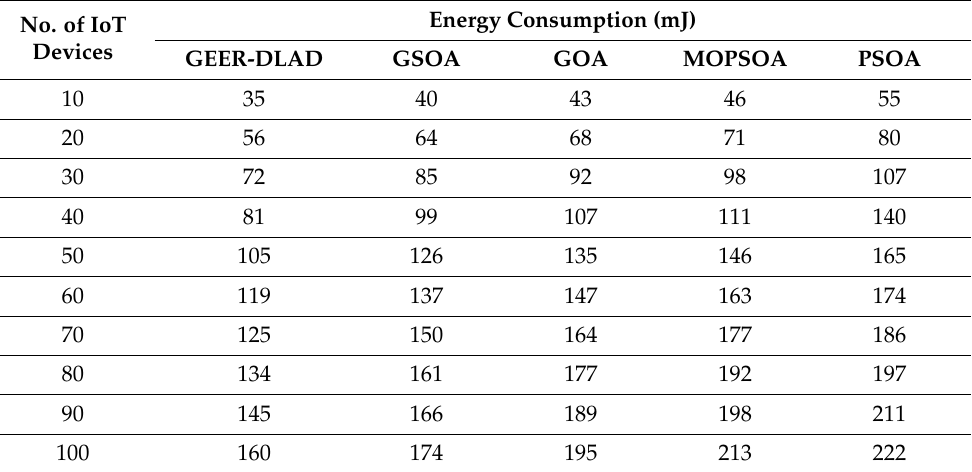
Table 1. The Result Analysis of Existing with Proposed GEER-DLAD Method in terms of Energy Consumption